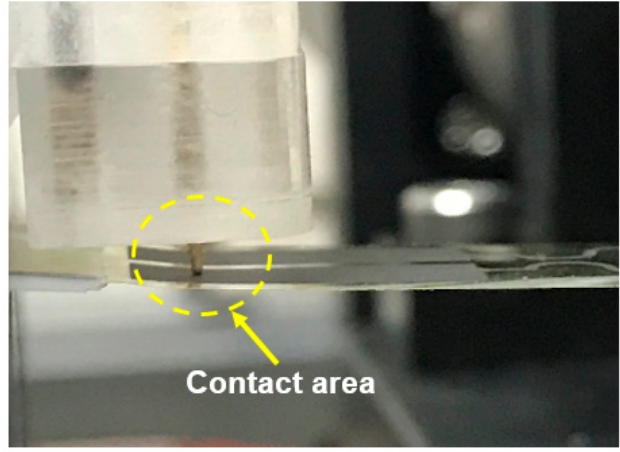
Figure 5. Enlarged view of the contact area between the probe and the tested specimen.